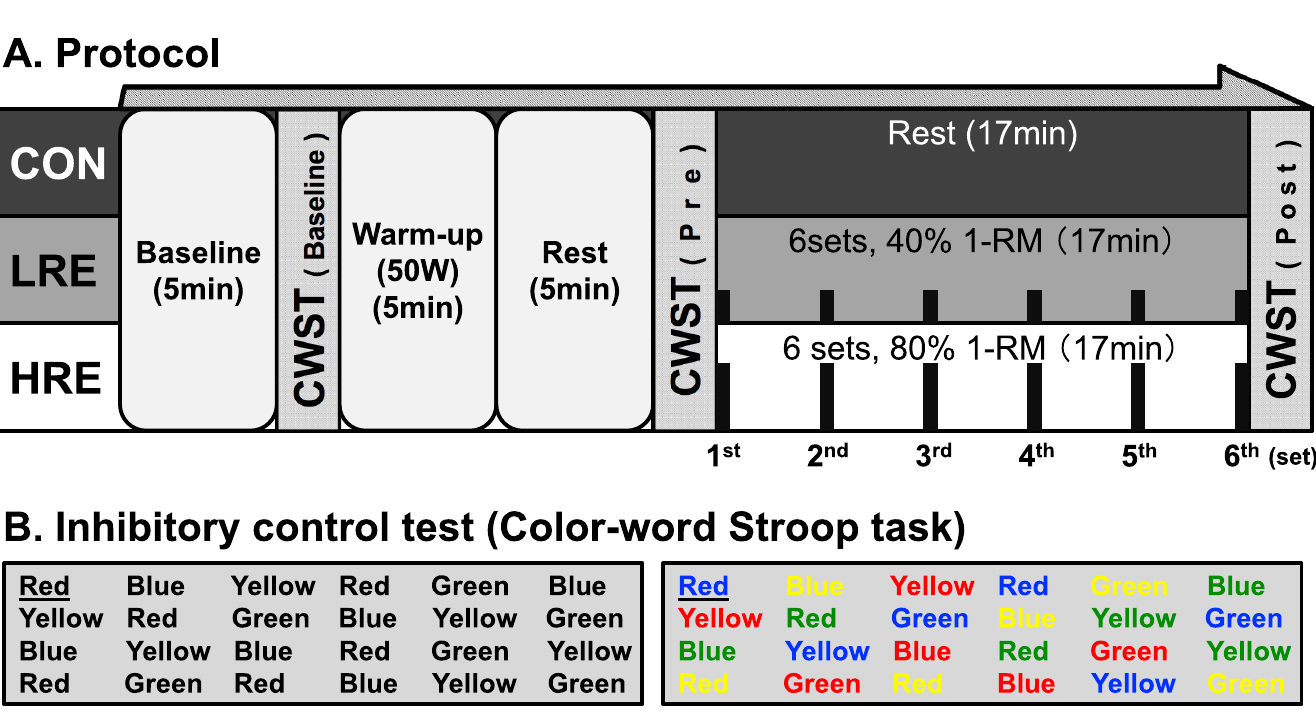
Fig 1. Experimental design and typical examples of the color-word Stroop task (CWST) measurement. Panel A shows the time line of the experimental session. To assess inhibitorycontrol (IC), the CWST was measuredat three time points: baseline,before (i.e., Pre) and immediately after (i.e., Post) the experimental session. The control (CON) conditionconsisted of the subject being at rest in a sitting position.The light-intensity resistance exercise (LRE) and high-intensity resistanceexercise (HRE) conditionswere appliedto 40% and 80% of the one-repetition maximum (1-RM), respectively. Both exercise conditions were programmed for 6 sets (displayed using black bars) with 10 repetitionsper set. The rest intervals betweensets lasted 3 min. The total experimental time was at 17 min. Panel B shows typical examplesof neutral and incongurent trials from the CWST. The neutral trial displaysthe color names presented in black text (e.g., when the word “RED” was printed in “black” ink, correct answer is “RED”). The incongruenttrial displaysthe color names presentedin a different-colored text (e.g., when the word “RED” was printed in “blue” ink, correct answer is “RED”).